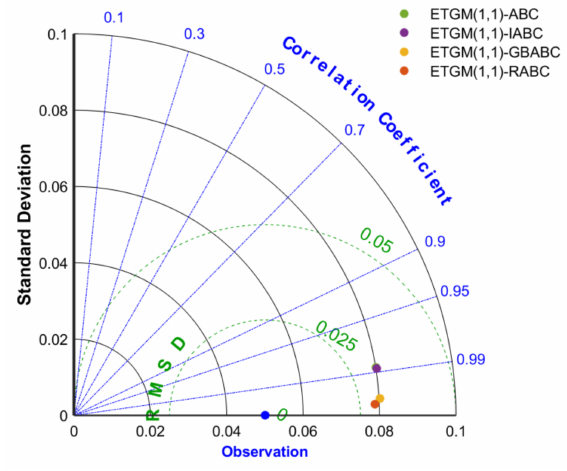
Figure 11. Accuracy comparison of four methods using the Taylor